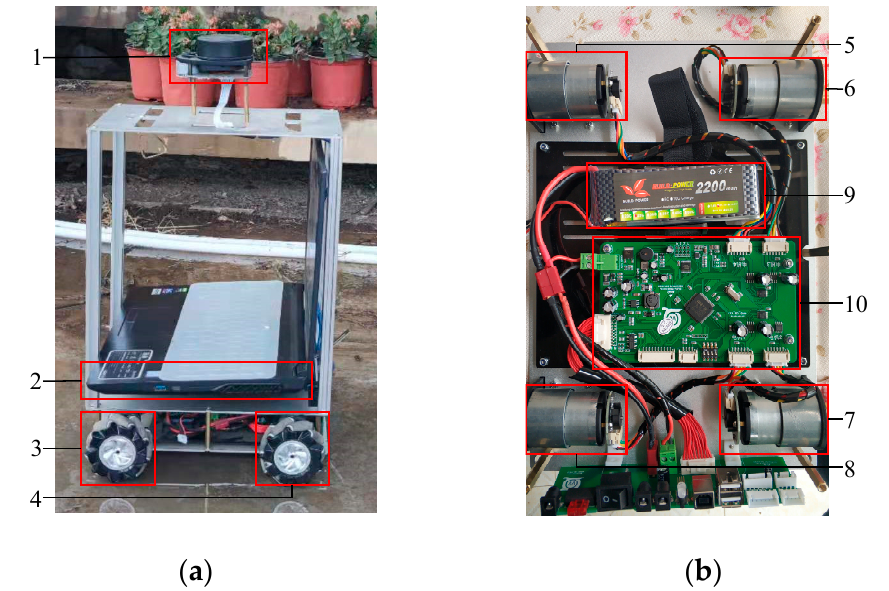
Figure 1. Mobile chassis prototype and hardware diagram: ( a ) Mobile chassis prototype. ( b ) Chassis hardware composition: 1. lidar; 2. laptop computer; 3–4. Mecanum wheels; 5–8. motors; 9. power supply; 10. control board.